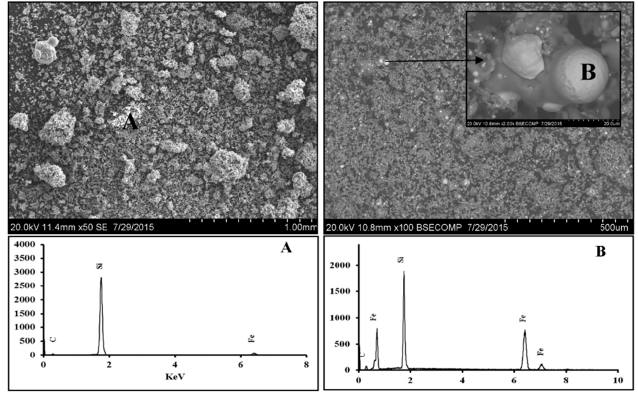
Figure 2. The presence of two distinct phases, “A” and “B”, in the SEM/EDS micrographs. Phase “A”, in the form of fine powder, mainly contains Si and C; and phase “B”, in the form of shiny metal droplets, has Si and Fe as its main constituents.